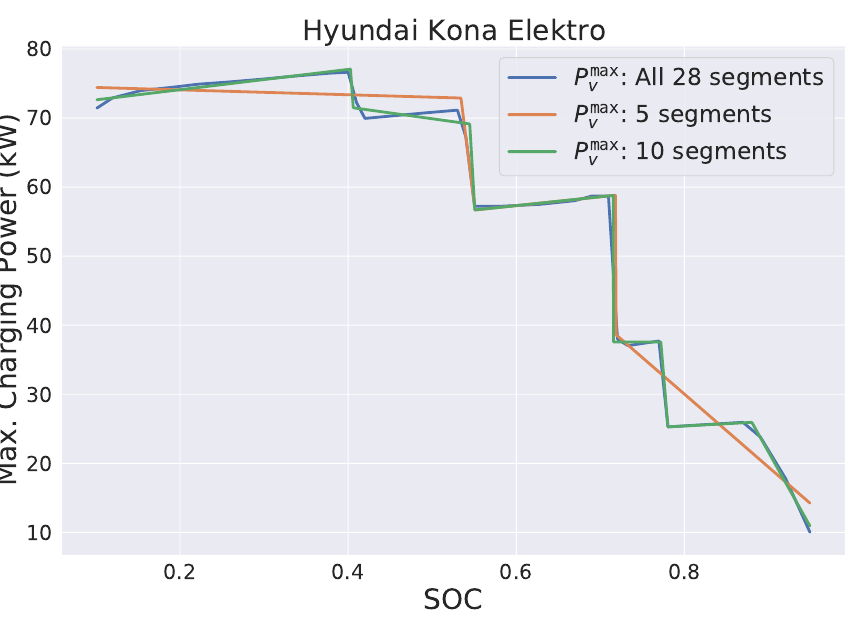
Figure 4. Exemplary P max v curve with different number of